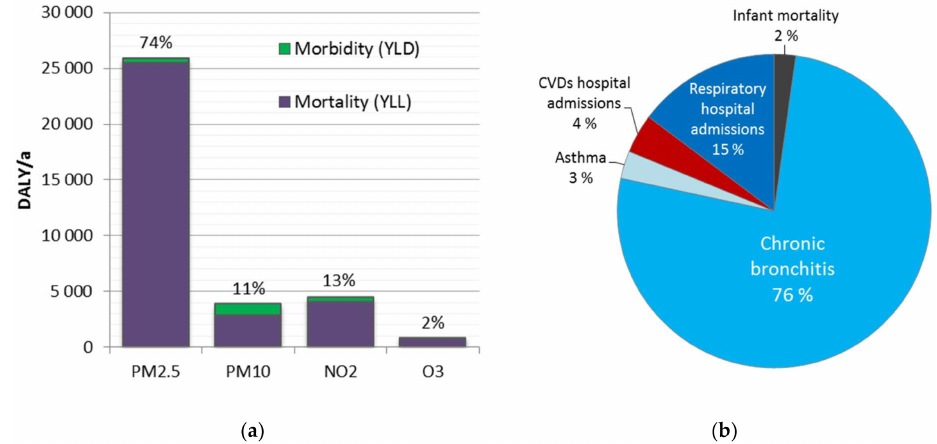
Figure 2. ( a ) Attributable disease burden for the four assessed air pollutants in Finland (35,000